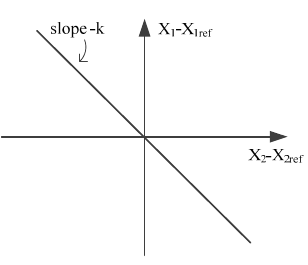
Figure 1. Geometric interpretation of the manifold in the phase plane.